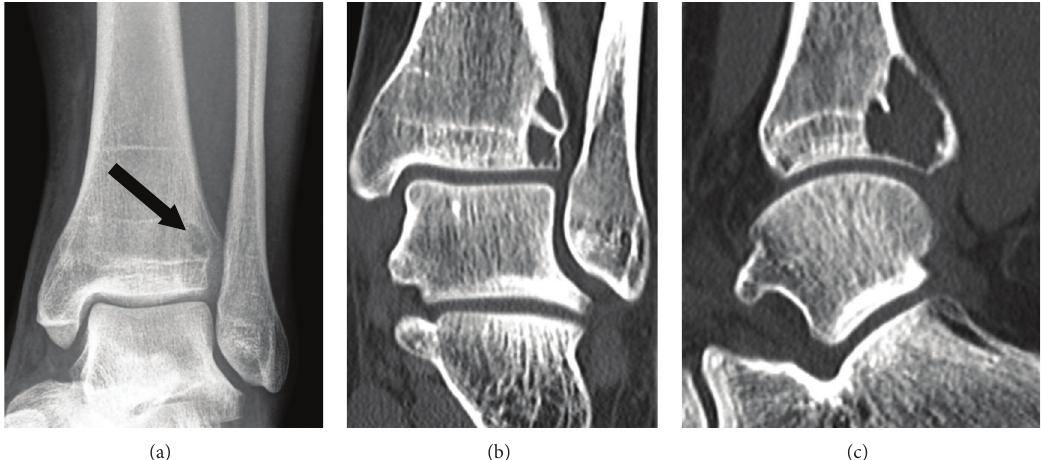
Figure 5: Conventional radiography and computed tomography of theleft distaltibia: (a) plain film(AP view) presents thelytic lesion(arrow) of the left lateral distal tibia, and (b) coronal and (c) sagittal CT sections can recognize the exact extension of the subchondral distal region of the dorsolateral left tibia.